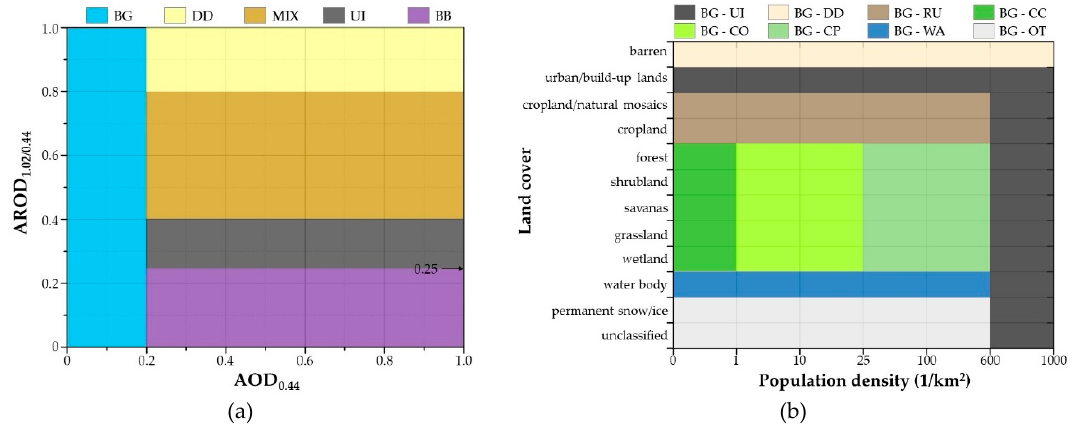
Figure 2. Aerosol-type classification methods used in this study. ( a ) A modified Aerosol optical Depth (AOD) – Aerosol Relative optical Depth AROD aerosol-classification method. BG, DD, MIX, UI, and BB denote the background, dust/desert dust, mixed, urban/industry, and biomass burning aerosols. ( b ) A background aerosol-subtype classification method was used to refine the BG aerosol type in (a). When AOD 0.44 was less than 0.2, BG-UI, BG-DD, BG-RU, BG-CC, BG-CO, BG-CP, BG-WA, and BG-OT represent the background aerosol subtypes of urban/industry, dust/desert dust, rural, continental clean, continental, continental polluted, water body, and other aerosol types, respectively.